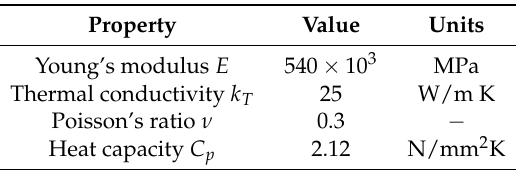
Table 4. Thermo physical properties of the